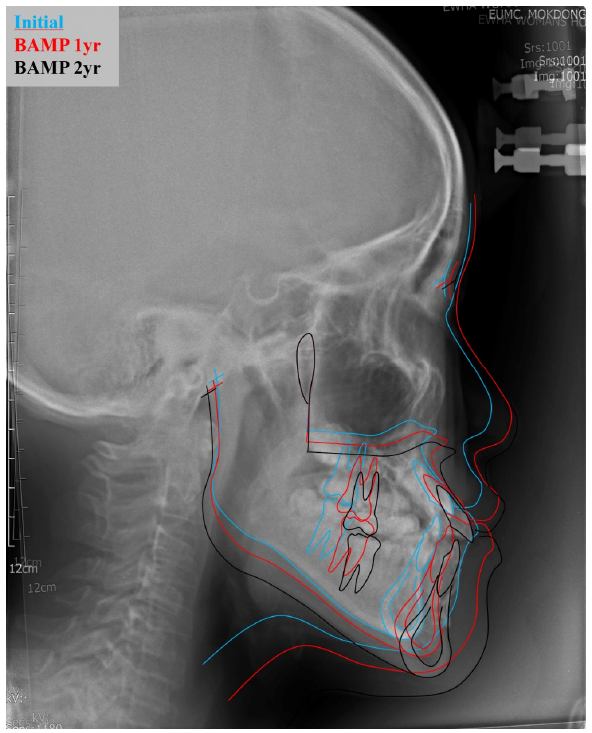
Figure 5. Superimposition of lateral cephalograms at initial stage, 12 months after BAMP therapy, and 24 months after BAMP therapy. The superimposition was based on the cranial base.